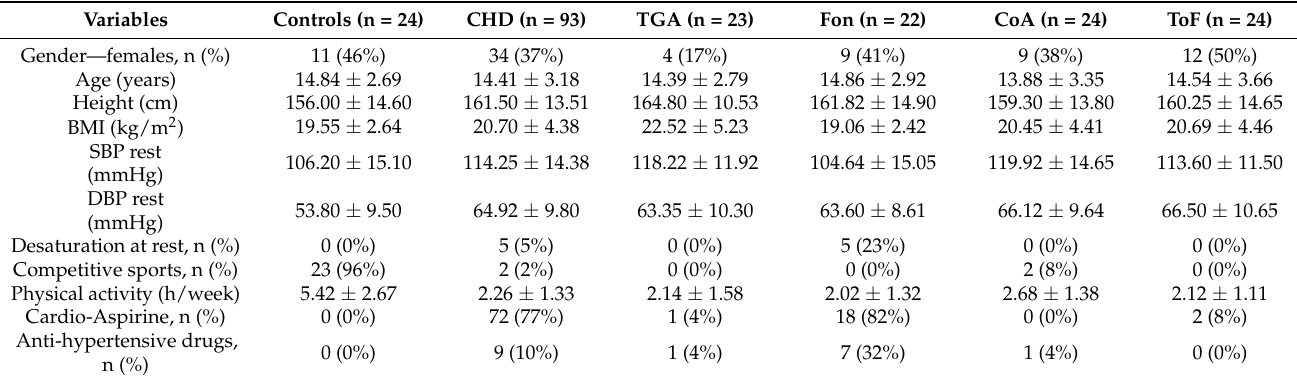
Table 1. Baseline characteristics of the healthy controls as well as of the patients with congenital heart disease (CHD). Data are expressed as a mean ± the standard deviation. BMI = body mass index; SBP = systolic blood pressure; DBP = diastolic blood pressure; TGA = transposition of great arteries; Fon = Fontan procedure; CoA = aortic coarctation; ToF = tetralogy of